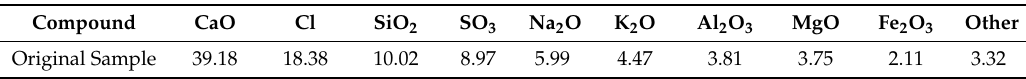
Table 2. Chemical composition of municipal solid waste incineration (MSWI) fly ash by X-ray fluorescence spectrometer (XRF) (wt